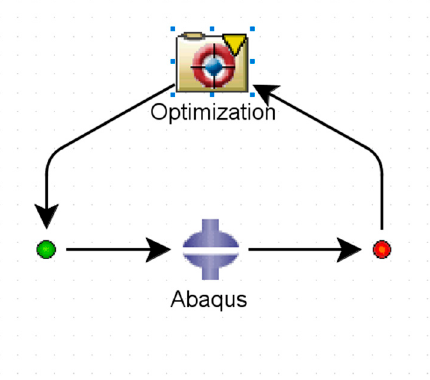
Figure 9. Optimization process loop.